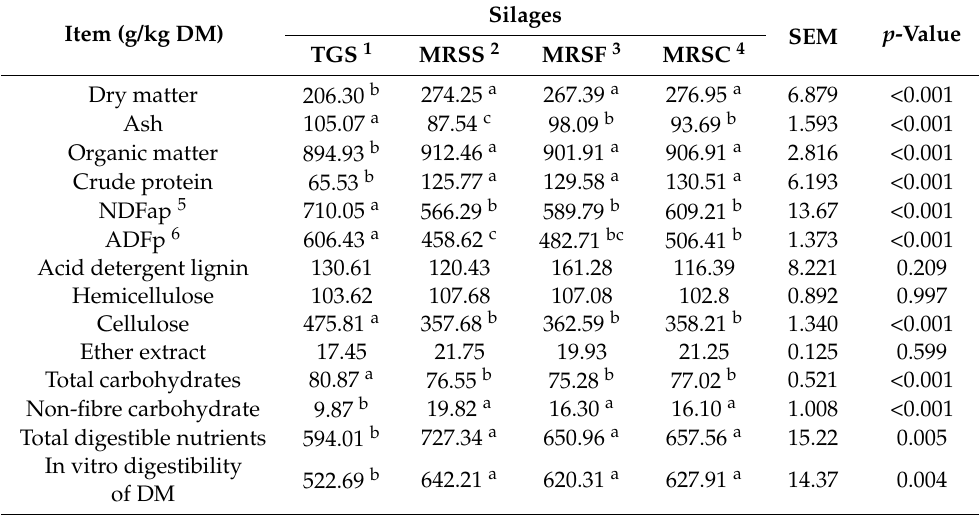
Table 4. Chemical composition and in vitro dry matter digestibility of total ration silages with babassu by-products.